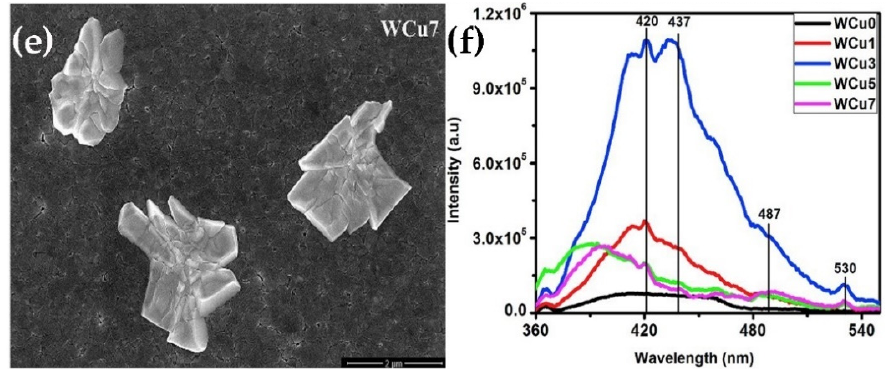
Figure 10. ( a – e ) FESEM images and ( f ) Photoluminescence emission spectra of the undoped and Cu doped WO 3 thin films. Reproduced or adapted from [60].